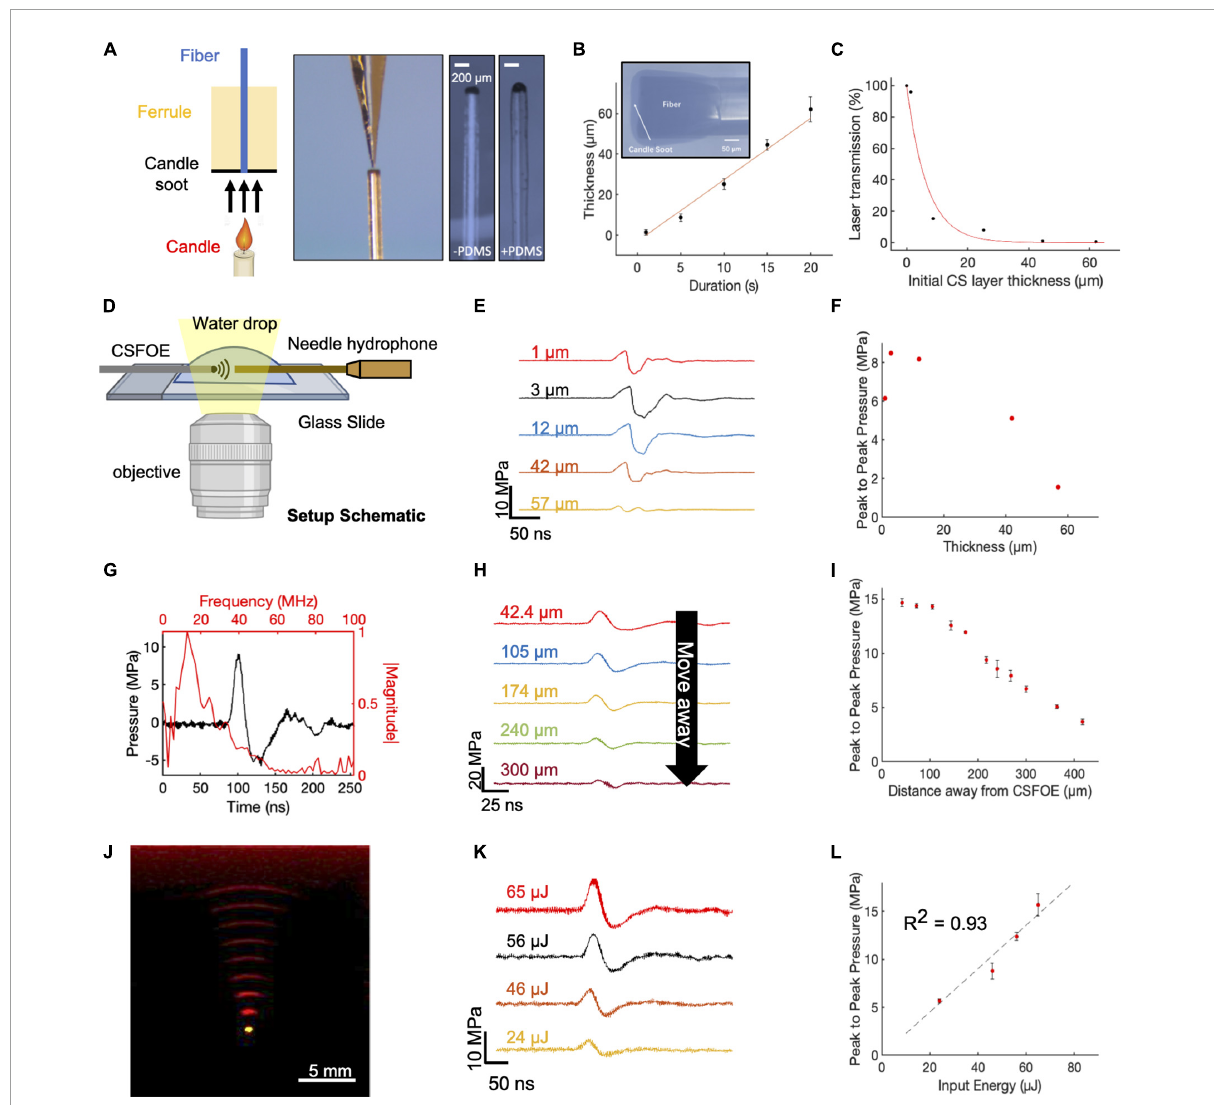
FIGURE2 Fabrication and characterization of CSFOE. (A) Key steps of CSFOE fabrication. (Left) Candle soot deposition on an optical fiber tip. (Middle) PDMS coating on the surface of the CS layer using a nanoinjector. (Right) Images of samples after CS deposition and PDMS coating, respectively. Scale bars: 200 µ m. (B) Thickness of the CS layer obtained as a function of deposition duration. Inset: representative image of a fiber coated with candle soot. (C) Transmission ratio plotted as a function of the thickness of CS layer. (D) Schematic of experimental configuration of photoacoustic signal measurement using a 40 µ m needle hydrophone. Created with BioRender.com. (E) Acoustic signal of CSFOE as a function of the candle soot layer thickness detected by the hydrophone. Laser condition: 1,030 nm, 1.7 kHz repetition rate, 46 µ J per pulse. (F) Peak to peak pressure plotted as a function of the thickness of CS under the same laser condition as (E) . (G) Representative photoacoustic waveform (Black) detected by the hydrophone and its FFT frequency spectrum (Red). laser condition: 1,030 nm, 56 µ J pulse energy. (H,I) Acoustic signal and peak-to-peak pressure generated by CSFOE detected at different distances from the CSFOE tip. Each data point was an average of three trials. laser condition: 1,030 nm, 56 µ J pulse energy, distance between hydrophone and CSFOE: 70 µ m (J) Photoacoustic signal propagation in the medium detected by a linear transducer array. Fiber tip (Yellow), PA waveform (red). (K,L) Photoacoustic waveforms and peak-to-peak pressures measured at different laser pulse input. Each data point was an average of three trials, distance between hydrophone and CSFOE: 70 µ